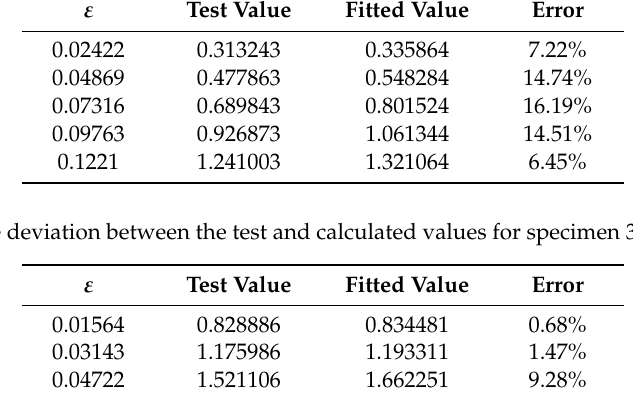
Table 17. The deviation between the test and calculated values for specimen 3 under 300 ◦ C ε